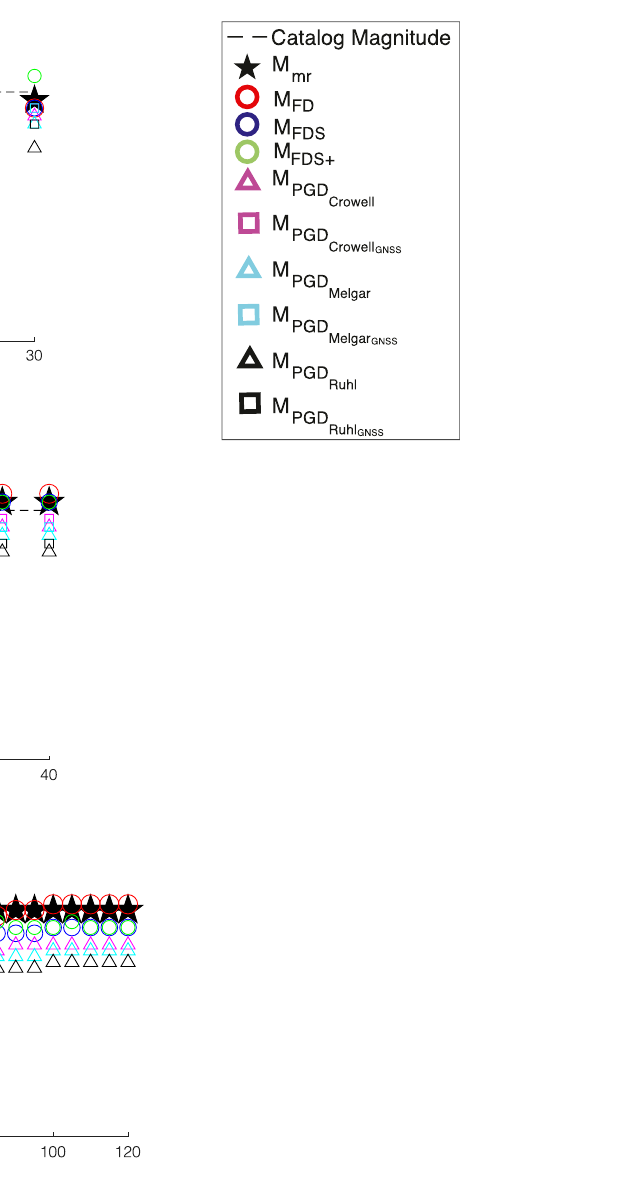
FIGURE 8 | Comparison of magnitudes from FinDer, FinDerS, FinDerS+, and PGD-based magnitude estimates as function of time from event origin for a) M W 7.1 Ridgecrest, b) M W 7.0 Kumamoto, and c) M W 7.9 Wenchuan. Triangles mark estimates derived from seismic and geodetic data, squares mark estimates from geodetic data only.